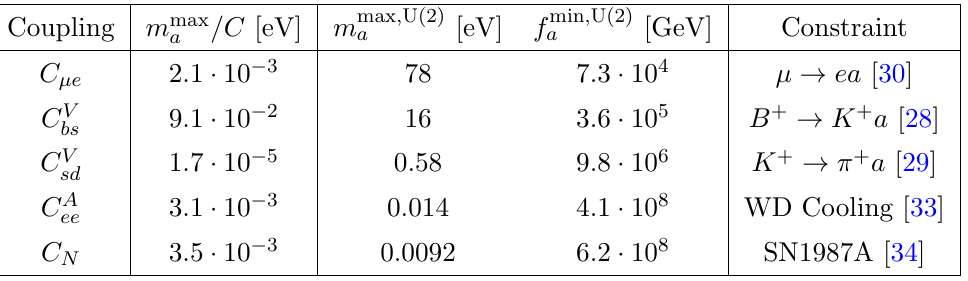
q ( C V ) 2 + ( C A ) 2 and C N (cid:17) (cid:22)e (cid:22)e